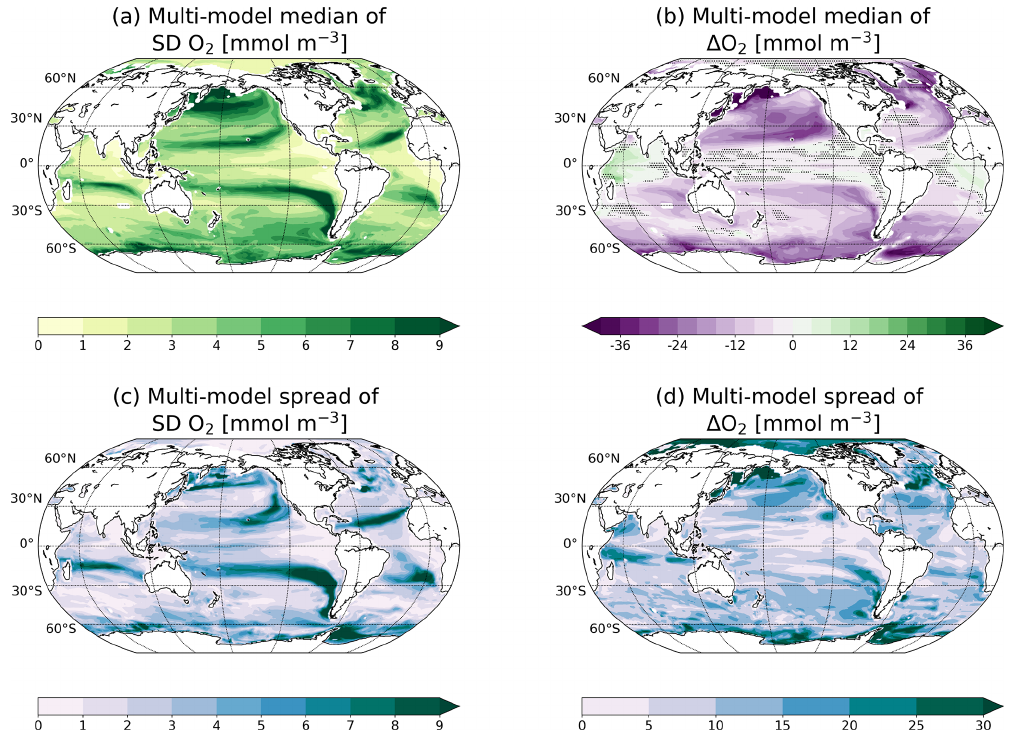
Figure 5. Median (a, b) and spread (c, d) of multi-model natural variability (standard deviation of control simulations; a , c ) and changes by the end of the 21st century (b, d) of O 2 between 200 and 600m. The hatched areas in panel (b) show regions where at least 70% of the models do not agree on (cid:49) O 2 sign. The individual responses for each model are shown in Figs. S5 and